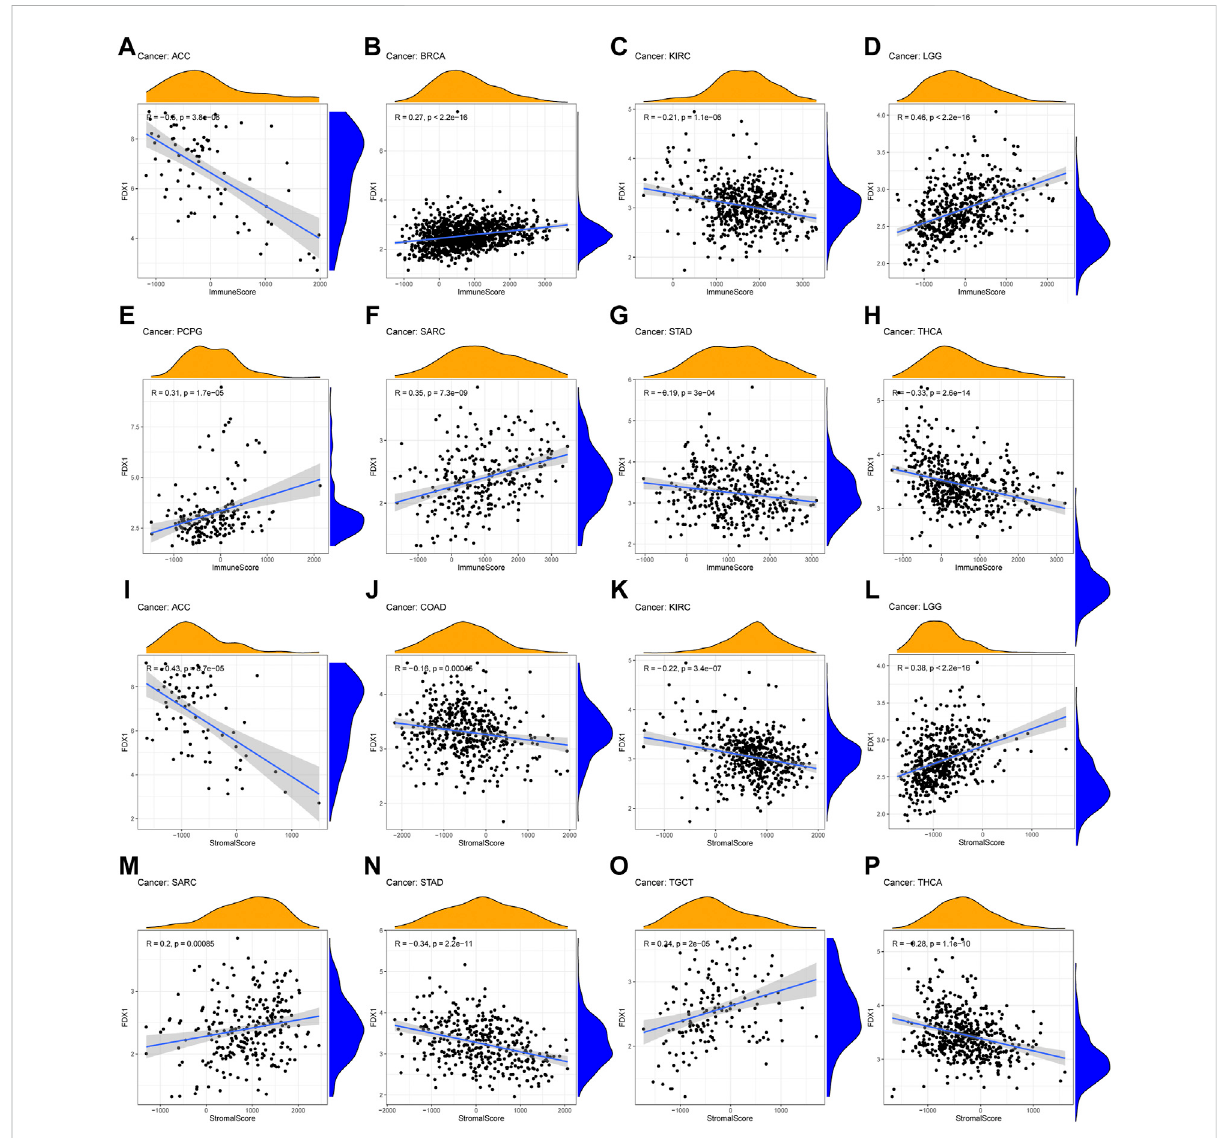
FIGURE 6 Association of FDX1 with the TME Composition (A – H) Immune score and (I – P) stromal score were analyzed to reveal the immune and stromal composition in